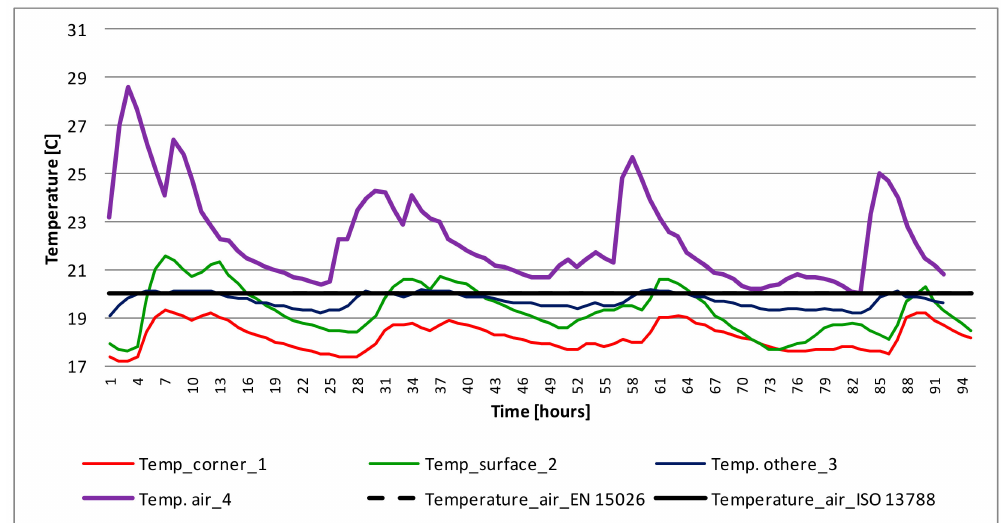
Figure 12. Changes in indoor air temperature for the room with external walls W_2 (symbols as in the picture Figure 5).